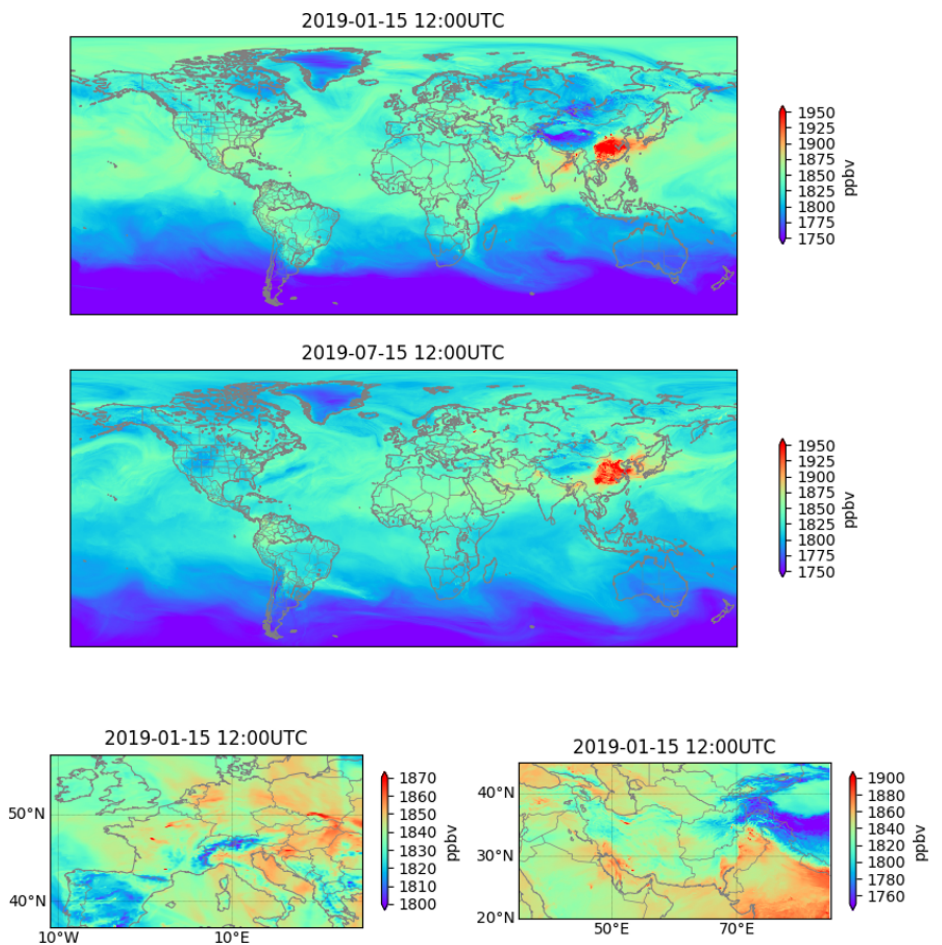
Figure 5. Examples of the IFS high-resolution CH 4 forecast output, showing snapshots at global and regional scales of the total column mean molar fractions for 15 January and 15 July 2019 at 12:00UTC. The lower panels show parts of Europe (left) and the Middle East